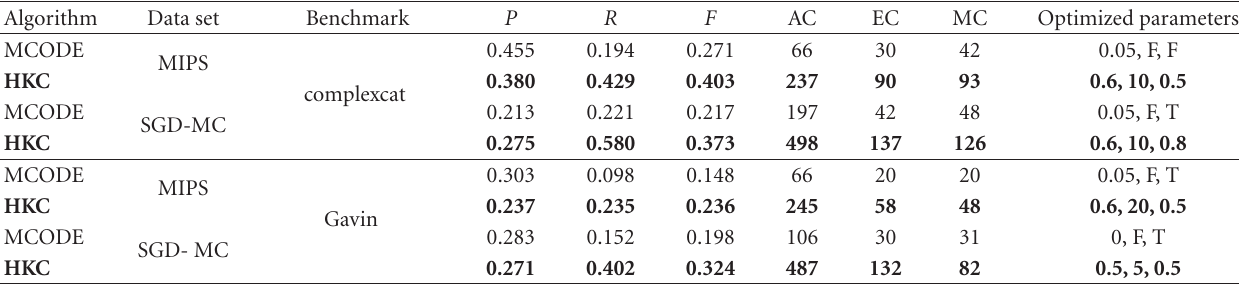
Table 1: Comparison with MCODE. P , R , and F stand for precision , recall, and F-measure, respectively, and their definitions are given in Section 3.1. MIPS data set contains 4,554 proteins and 12,526 interactions, and SGD-MC data set contains 4,448 proteins and 29,068 interactions. AC is the number of all clusters predicted by the algorithm; EC is the number of e ff ective clusters (with a least one matching complex above overlap ratio 0.4) found by the algorithm; MC is the number of matched complexes in the benchmark set. The sizes of complexcat benchmark and Gavin benchmark are 217 and 204, respectively. For HKC the optimized parameters are T 1 , T 2 , and T 3 , respectively, and for MCODE the optimized parameters are NodeScoreCuto ff , flu ff (T for true, F for false), haircut (T for true, F for false), and other unspecified parameters adopt the default